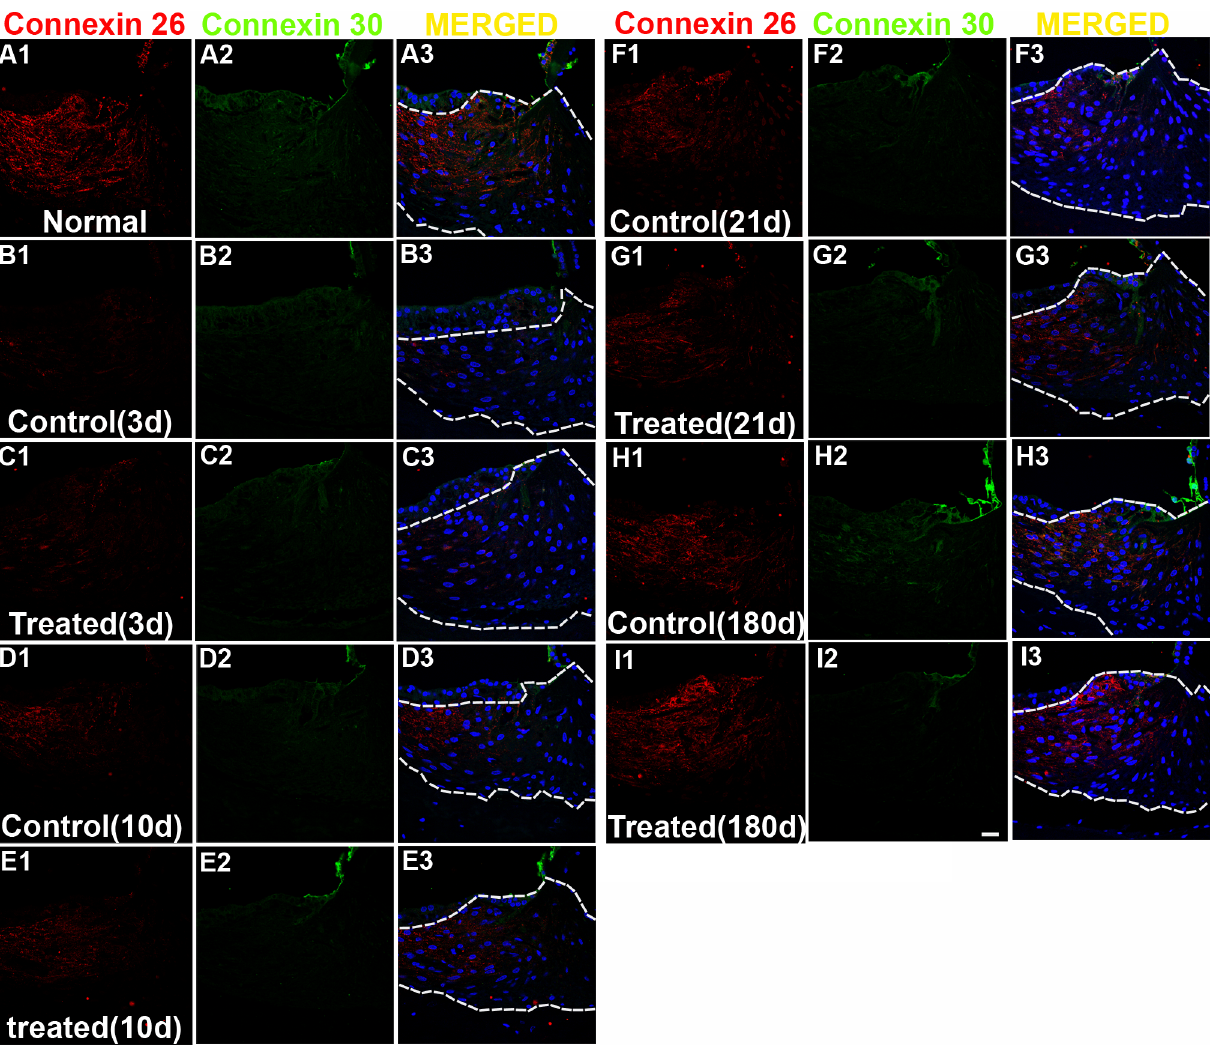
Fig 13. Representative confocal images of connexin 26 (red) and 30 (green) labeling collected from the spiral ligament. Nuclei of cells were stained by DAPI (blue). Mergedimages are shown in the column 3 (A3-I3, merged). Positive Connexin26 labeling(red) is observedin fibrocytes in the spiral ligamentof normal (na ï ve)controls (A1). Decreased connexin26 labeling(column1) is observedin the spiral ligament of chinchillaall time points after noise exposure (B-H) except in the treated group at 6 months after noise exposure(I). No or very low CX-30 labelingis observed in fibrocytes of the spiral ligament of chinchillawhilethe root cells show positive Cx-30 labeling(A2-I2). Scale bar = 20 μ m in I3 for A1-I3.